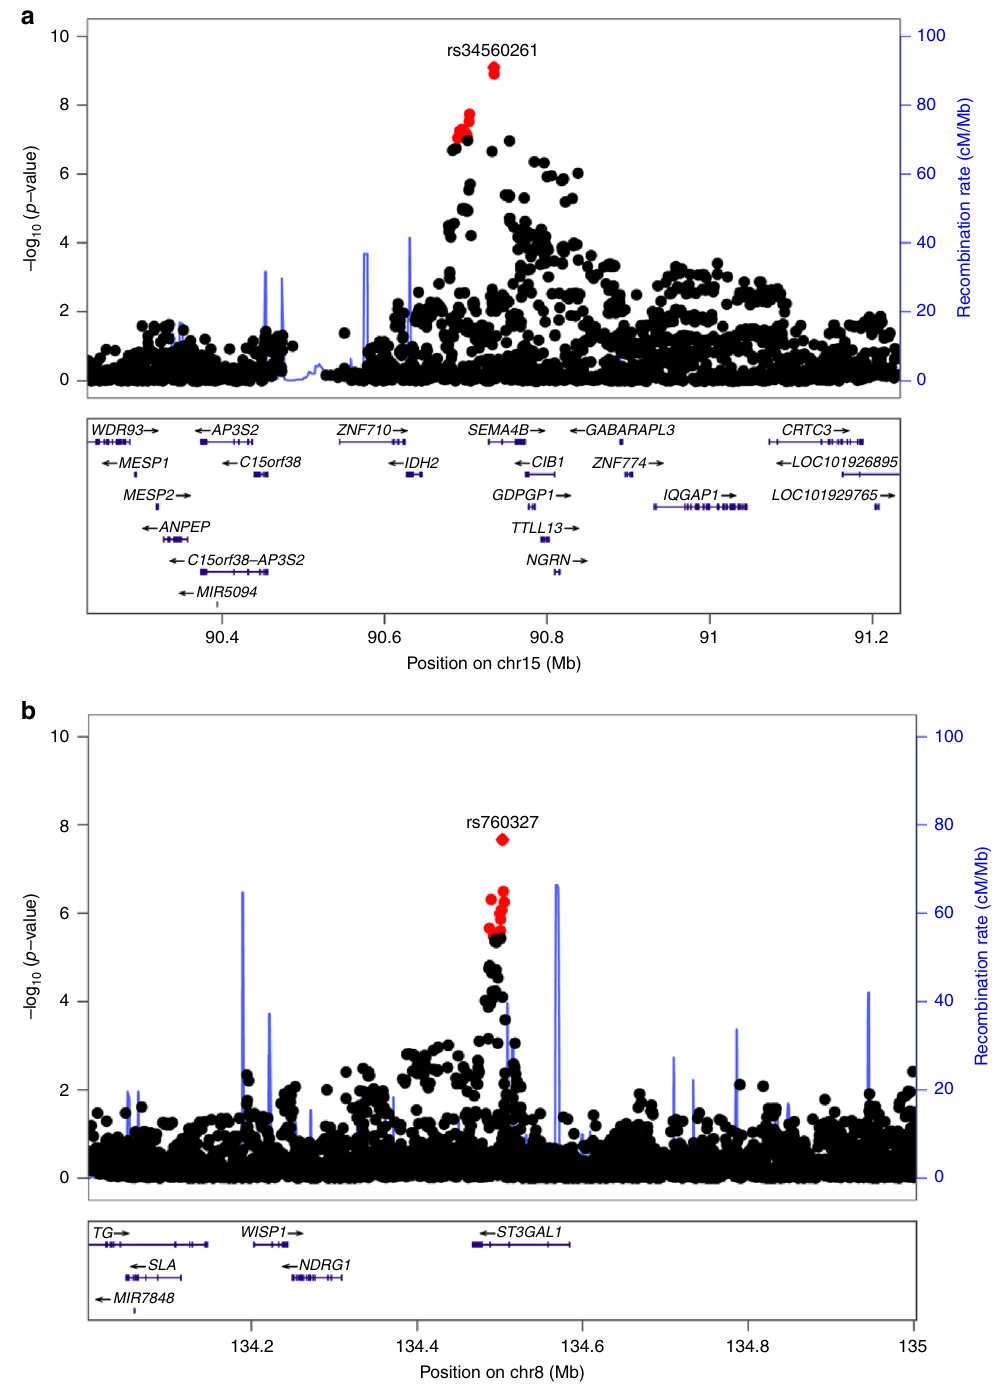
Fig. 3 Regional plots of lead signals at loci 15q26.1 and 8q24.22. a Regional plot at locus 15q26.1 (rs34560261); and b Regional plot at locus 8q24.22 (rs760327). The blue lines shows the fi ne-scale recombination rates (right y axis) estimated from individuals in the 1000 Genomes population; genes are highlighted with horizontal lines; the x axis shows the chromosomal position in Mb; variants within the 95% credible set are highlighted in